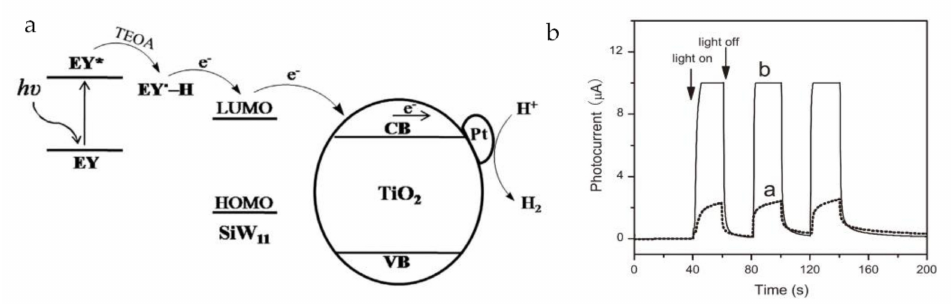
Figure 4. ( a ) Probable mechanism of hydrogen production in EY sensitized SiW 11 /TiO 2 . ( b ) The photocurrent responses of ( a ) EY-TiO 2 and ( b ) EY-SiW 11 /TiO 2 electrode under 520 nm visible light irradiation